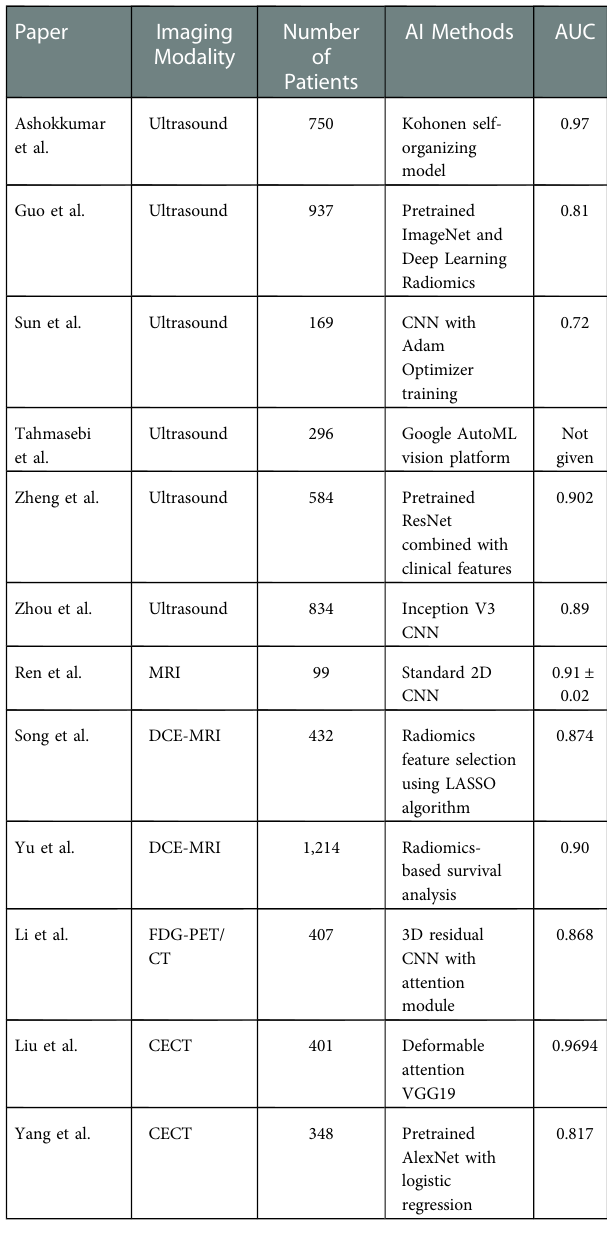
TABLE 1 Summary table of recent literature discussed in review comparing different AI methods and AUC for identifying axillary lymph node